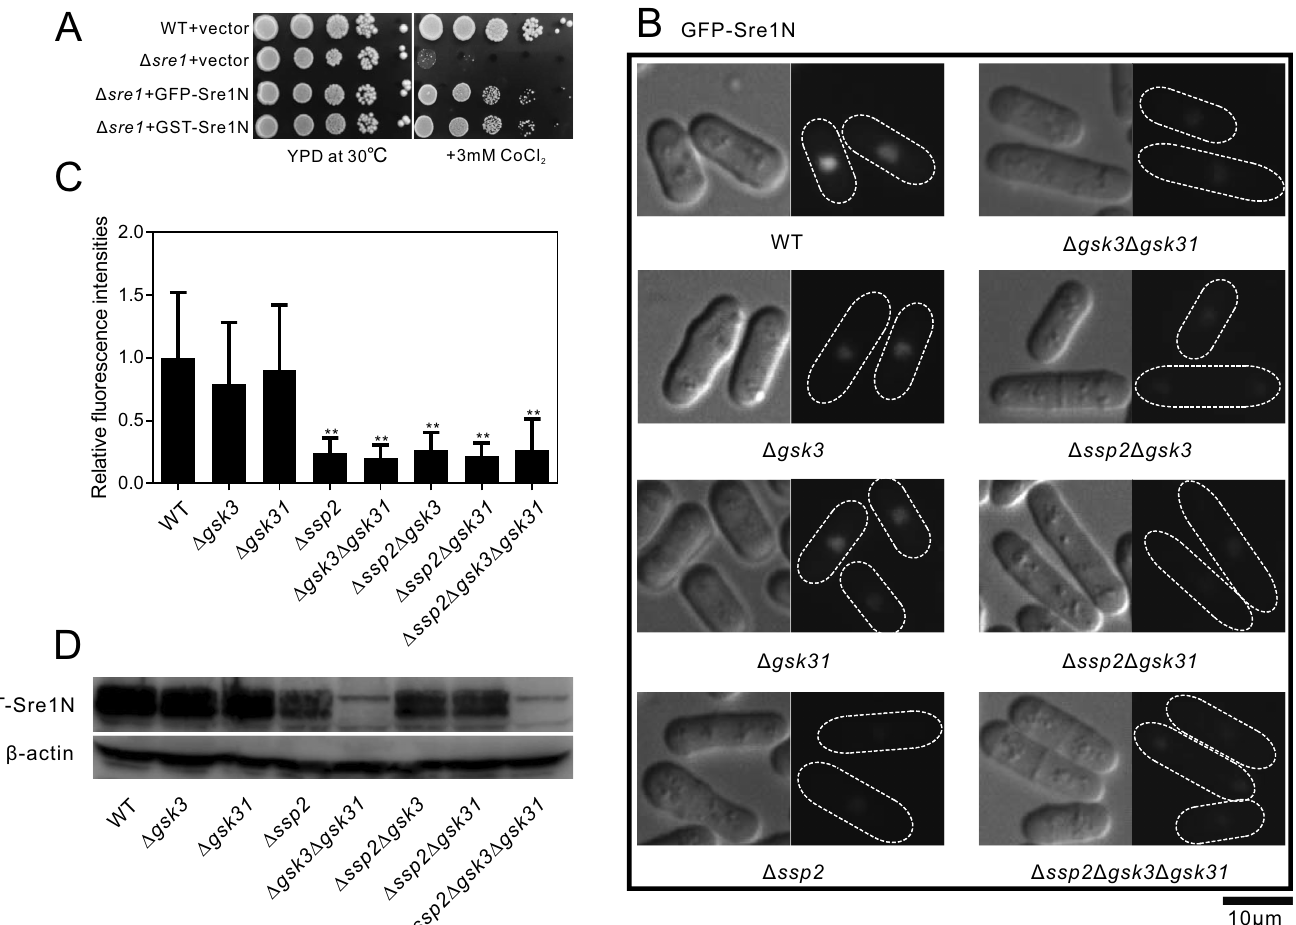
Fig 6. Deletion of Ssp2 or/and Gsk3/Gsk31 reduced the nuclear fluorescence of GFP-Sre1N as well as GST-Sre1N protein levels. (A) Both GFP-Sre1N and GST-Sre1N complemented the CoCl 2 -sensitive growth defect of the Δ sre1 cells. Cells transformed with the empty vector, the pREP1-GFP-Sre1N plasmid or pREP1-GST-Sre1N plasmid were spotted onto each plate as indicated, and then incubated at 30˚C for 4 days. (B) Significantly weaker fluorescence of GFP-Sre1N at the nucleus was observed in Δ ssp2 , Δ gsk3 Δ gsk31 , Δ ssp2 Δ gsk3 , Δ ssp2 Δ gsk31 or Δ ssp2 Δ gsk3 Δ gsk31 cells. Wild-type, Δ gsk3 , Δ gsk31 , Δ ssp2 , Δ gsk3 Δ gsk31 , Δ ssp2 Δ gsk3 , Δ ssp2 Δ gsk31 or Δ ssp2 Δ gsk3 Δ gsk31 cells expressing GFP-Sre1N were grown in EMM medium with 4 μ M thiamine at 30˚C for 16 h, and then observed by fluorescence microscopy for the same 3 seconds exposure. Bar, 10 μ m. (C) Fluorescence intensity quantification of GFP-tagged nucleus Sre1N. Fluorescence intensities of about 50 cells from each strain cultured at 30˚C were measured. Average values after background subtraction are shown in the bar graph. Error bars represent standard deviations. (D) The whole amount of Sre1N was markedly reduced in the Δ gsk3 Δ gsk31 or Δ ssp2 Δ gsk3 Δ gsk31 cells but just a little reduced in the Δ ssp2 , Δ ssp2 Δ gsk3 or Δ ssp2 Δ gsk31 cells as assessed by immunoblot analysis. Wild-type, Δ gsk3 , Δ gsk31 , Δ ssp2 , Δ gsk3 Δ gsk31 , Δ ssp2 Δ gsk3 , Δ ssp2 Δ gsk31 or Δ ssp2 Δ gsk3 Δ gsk31 cells